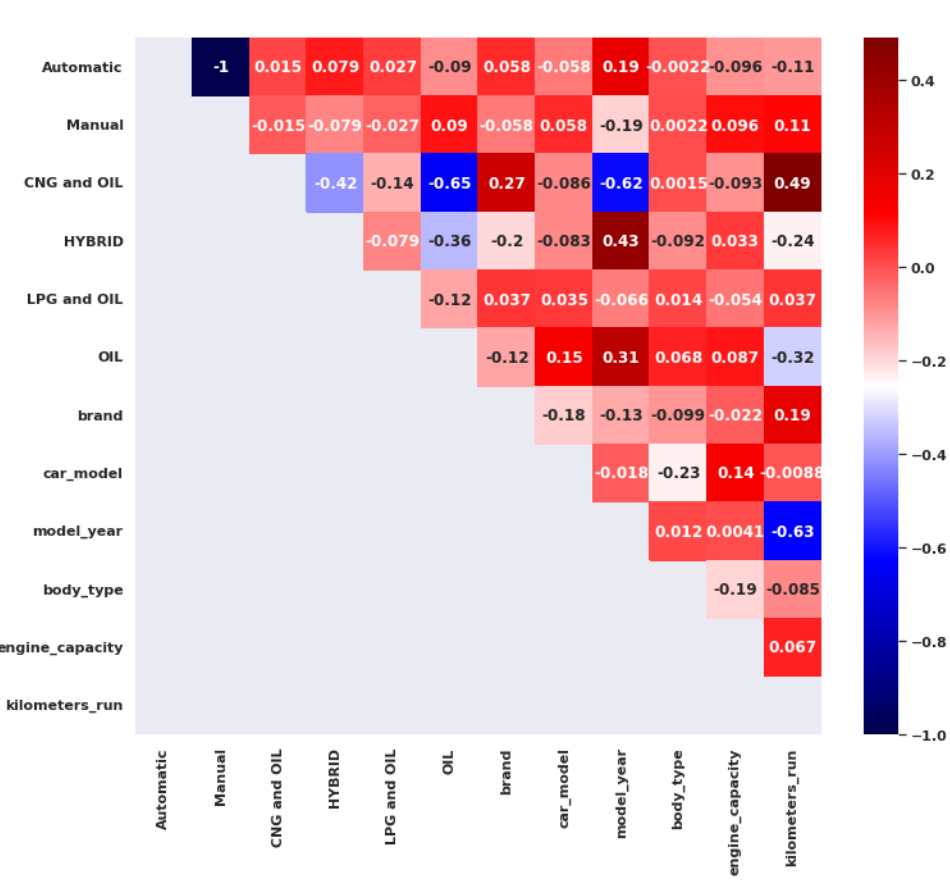
Figure 16. Heat map between every pair of features.